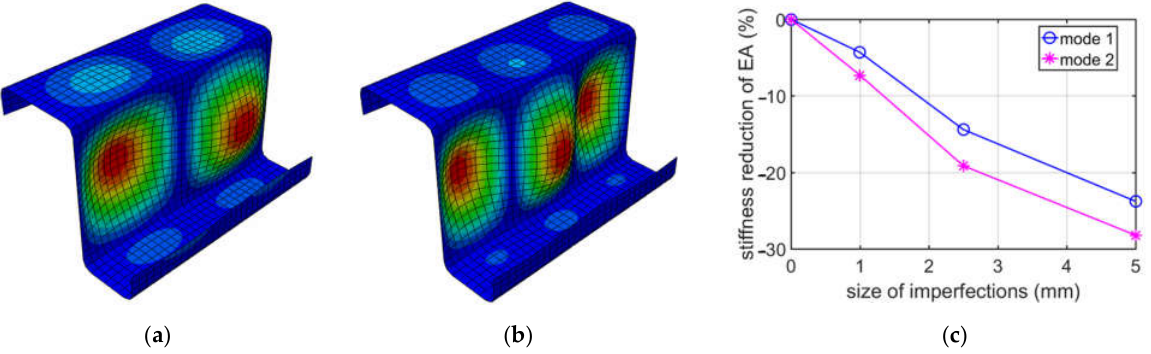
Figure 5. Buckling in compression for 150 mm depth: ( a ) mode 1; ( b ) mode 2; ( c ) plot of the stiffness reduction of EA, depending on the size of